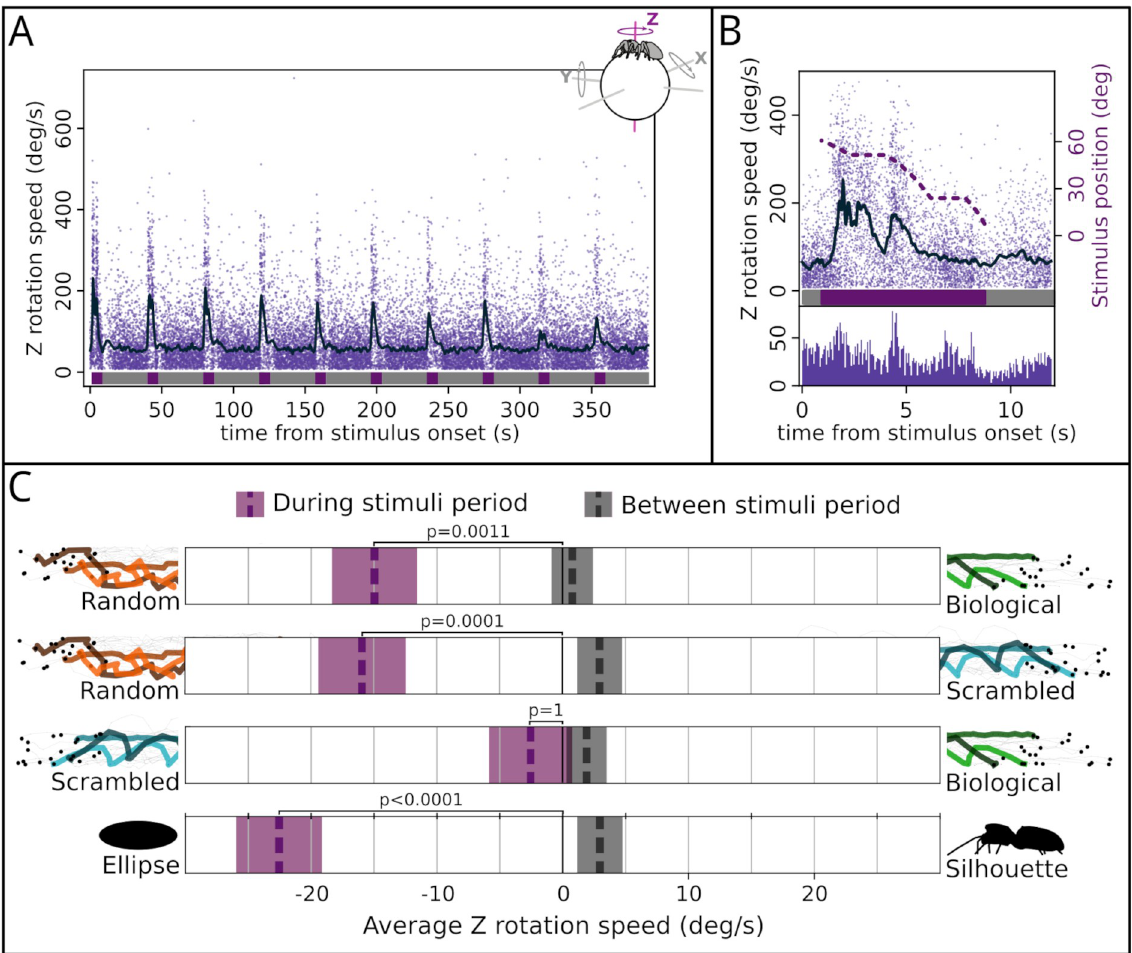
Fig 2. Results. (A) Recorded peak rotation speeds for each trial (every set of 10 stimuli pair presentations; n trials = 188; n spiders = 60). The x-axis represents time (in seconds) from the start of the experiment, and the y-axis represents rotational speed (in degrees per second). Individual dots represent peaks, while the dark line shows the running average. In the top-right corner, a schematic representation of the spider on top of the sphere, with the 3 possible axis of rotation. The data presented in this and the following graphs refer to rotation observed on the sphere’s z- axis, which correspond to the spider’s saccades. Below, colors show when the stimuli were onscreen (purple) or not present (gray). When stimuli are present, the average rotational speed increases, while when stimuli are not present, peak rotational speed remains low. This suggests that rotational speed is representative of saccades and that spiders are turning toward stimuli (see Materials and methods section). (B) Time- aligned responses across all stimuli. Upper portion: same as panel A, with addition of right y-axis indicating position of the stimuli on the screen (in degrees from the center, dashed purple line). Below portion: histogram of the peaks frequency. Peak frequency increases when the stimuli are moving and decreases when they are stationary (flat sections of the stimulus position line). (C) Stimulus preference for each condition. The x-axis represents the rotational speed. Positive or negative values correspond to a preference for the stimulus indicated. Purple boxes refer to sections when the stimuli were visible (during stimuli period), and gray boxes refer to sections when stimuli were not visible (between stimuli period). Dashed lines in the box represent the average, and shaded areas represent SE. For this analysis, every peak was either positive, when turning toward the stimulus depicted on the right of the graph (the one with biological characteristics), or negative, when turning toward the stimulus shown on the left. Thus, average speed is a proxy of relative preference, with 0 corresponding to no preference. For the biological versus random, scrambled versus random, and silhouette versus ellipse, the spiders preferred the less realistic stimulus. We observed no preference in the biological versus scrambled condition. Across all conditions, there was no preference during the 30-second between-stimuli period. Data underlying panels A and B are available in S1 Data. Panel C depicts result of the GLMM based on the same data. The analysis script is available in S2 Analysis. GLMM, generalized linear mixed model; SE, standard error.